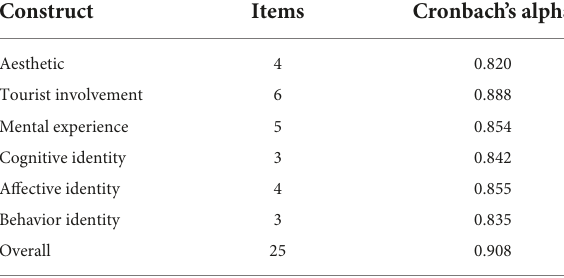
TABLE 2 Results of confirmatory factor